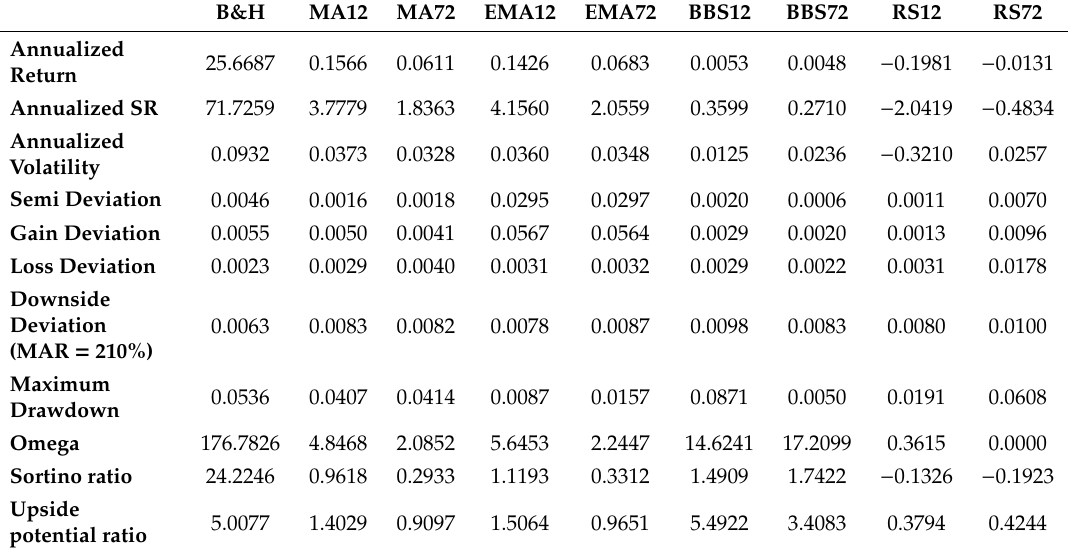
Table 4. Intraday strategies results.